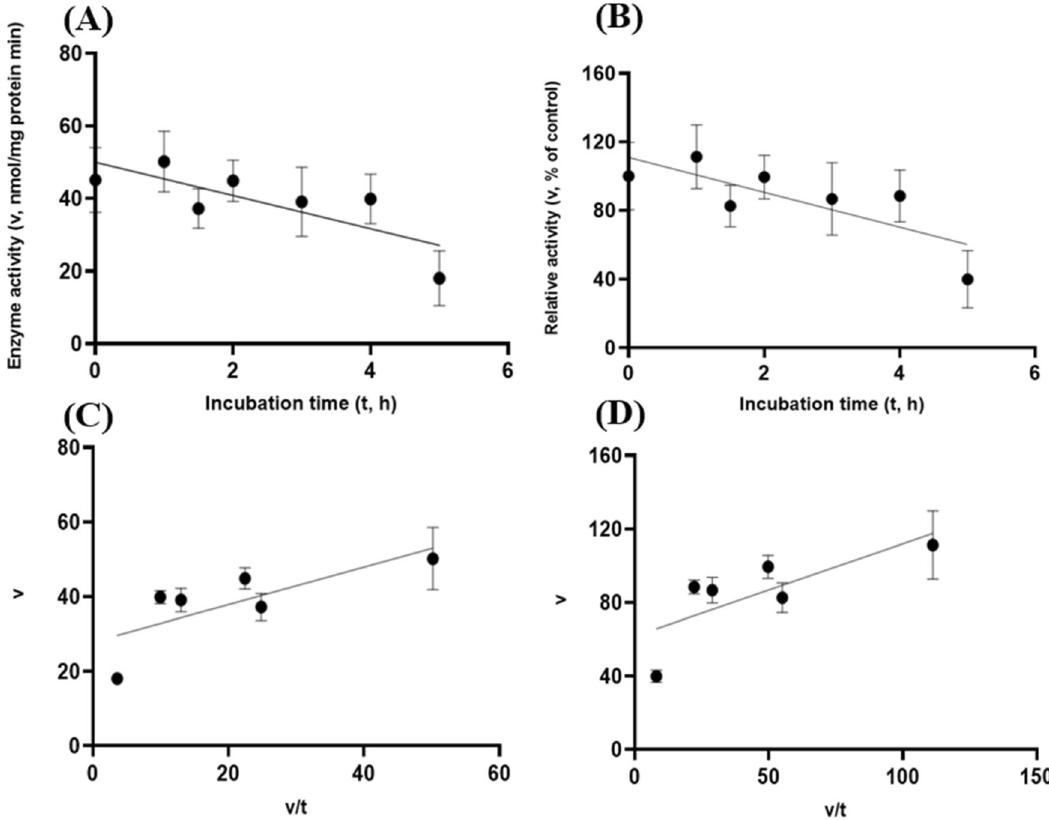
Figure 6. Experiment-2 of the gastric acidic pH effects (pH = 3.5) (with describing model parameter estimates ± SE ) on GH5-tCel5A1 activity over a 5-h period after the gastric pH buffer being mixed with the crude GH5-tCel5A1 enzyme preparation prior to further incubation for measuring cellulase activity with the carboxymethyl cellulose (CMC) substrate buffer in presence of dithiothreitol (DTT) (5 mM) and N 2 gas purging for 15 min at 37 °C. (A) Exponential plot of the inhibition kinetic relationship between GH5-tCel5A1 activity (v, mean ± SE, n = 12at each time point, nmol/mg protein•min) and incubation time (t, h) under gastric pH 3.5 established conditions according to the exponential response model as: Y = 48.398 ( ± 5.710 ) e [ − 0.099 ( ± 0.049 ) x ) ] , P < 0.0001 for the initial residual tCel5A1 activity estimate; and P = 0.045 for the rate constant estimate; R 2 = 0.080 , n = 84; and alternatively, according to the linear response model established as y = 48.644 ( ± 5.127 ) − 4.193 ( ± 1.782 ) x , P < 0.0001 for the intercept; and P = 0.021 for the slope, r 2 = 0.087 , n = 84; (B) Exponential plot of the inhibition kinetic relationship between relative GH5- tCel5A1 activity (v, mean ± SE, n = 12at each time point, % of the control group measured (100.000 ± 19.72) at 0-min exposure to the gastric pH-3.5 incubation) and incubation time (t, h) under gastric pH 3.5 conditions according to the exponential response model established as: Y = 107.3 ( ± 12.664 ) e [ − 0.099 ( ± 0.049 ) x ) ] , P < 0.0001 for the initial residual GH5-tCel5A1 activity estimate; and P = 0.045 for the rate constant estimate; R 2 = 0.080 , n = 84; and according to the linear response model established as y = 107.9 ( ± 11.369 ) − 9.299 ( ± 3.952 ) x , P < 0.0001 for all parameter estimates, r 2 = 0.087 , n = 84; (C ) the Eadie-Hofstee linear plot between the GH5- tCel5A1 enzyme activity [v, mean ± SE, n = 12at each data point, nmol/mg protein•min] and the v/t ratio established as y = 17.637 ( ± 3.067 ) − 1.008 ( ± 0.113 ) x , P < 0.0001 for all parameter estimates; r 2 = 0.564 , n = 72; and (D ) the Eadie-Hofstee linear plot between the relative GH5-tCel5A1 enzyme activity [v, mean ± SE, n = 12at each data point, % of the control group, I c at 100.000 ± 19.72) measured at 0-min exposure gastric pH-3.5 incubation] and the v/t ratio established as y = 39.114 ( ± 6.801 ) − 1.008 ( ± 0.113 ) x , P < 0.0001 for all parameter estimates;, r 2 = 0.564 , n =